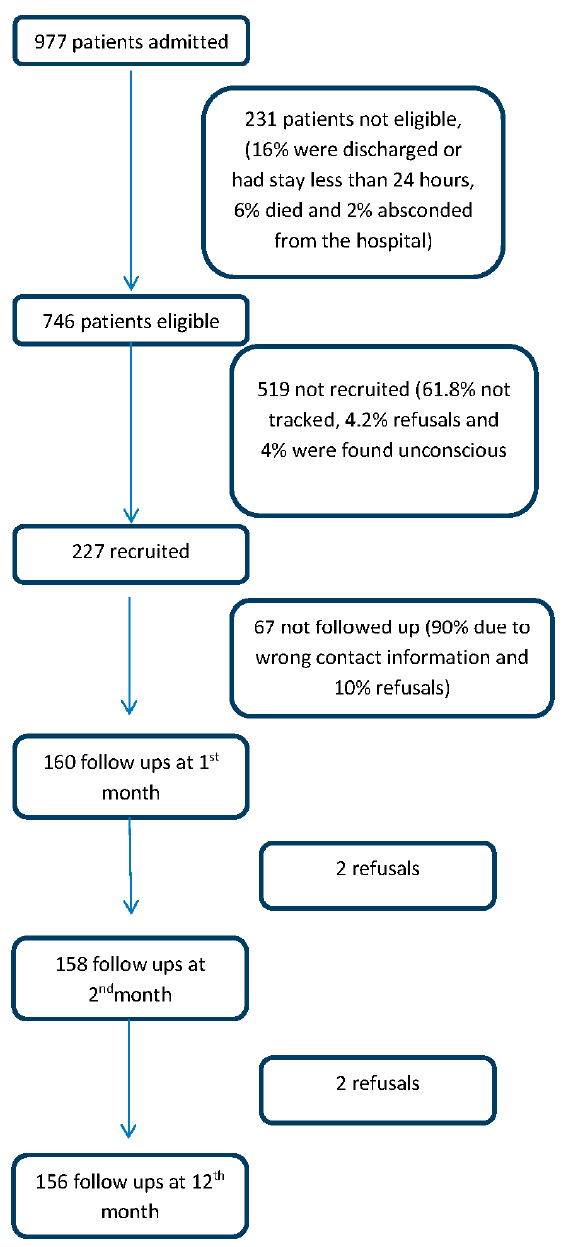
Figure 1. Flowchart showing recruitment procedure.